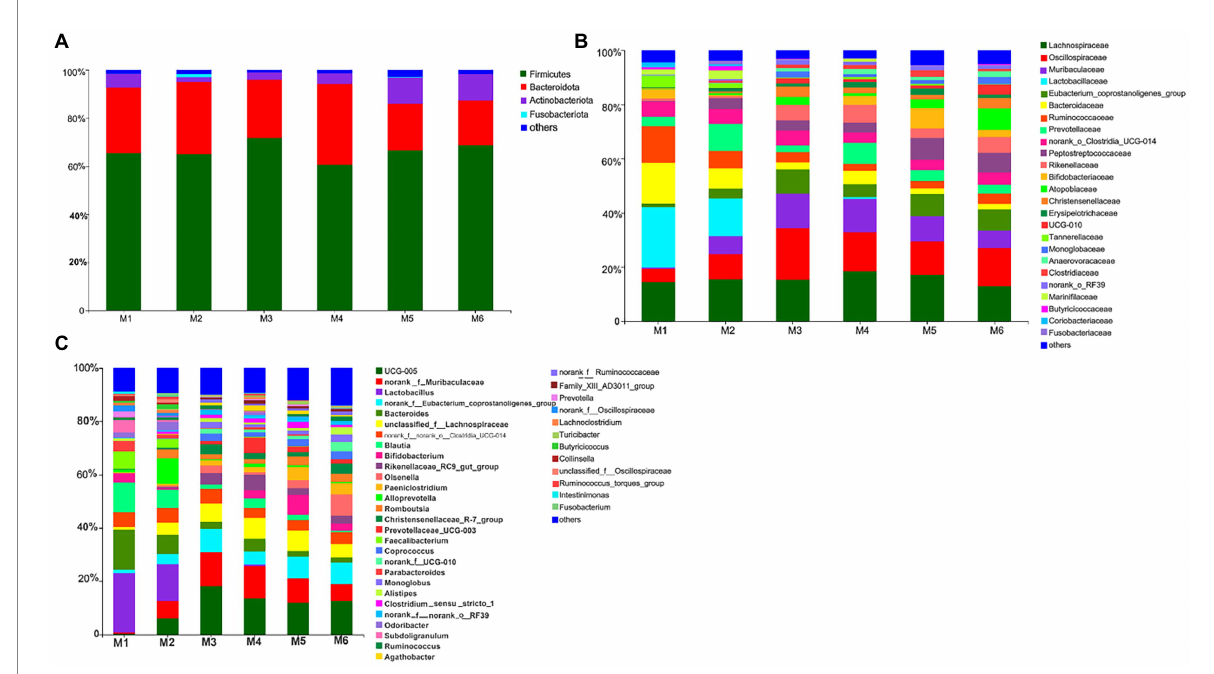
FIGURE 3 Composition of the fecal bacteria at the phylum (A) , family (B) , and genus levels (C) in different-age calves in Tibet. Others, bacteria with relative abundance ≤ 0.01%; the number of calves in each of the six groups was